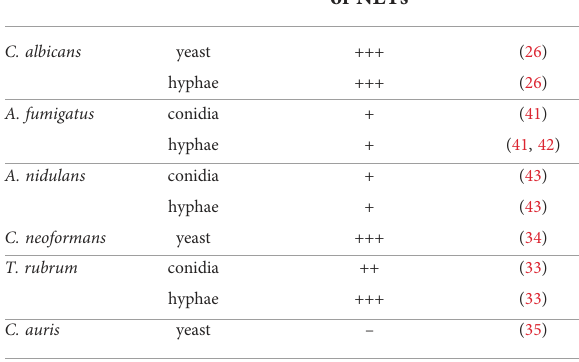
TABLE 1 Role of NETs in different fungal infections.